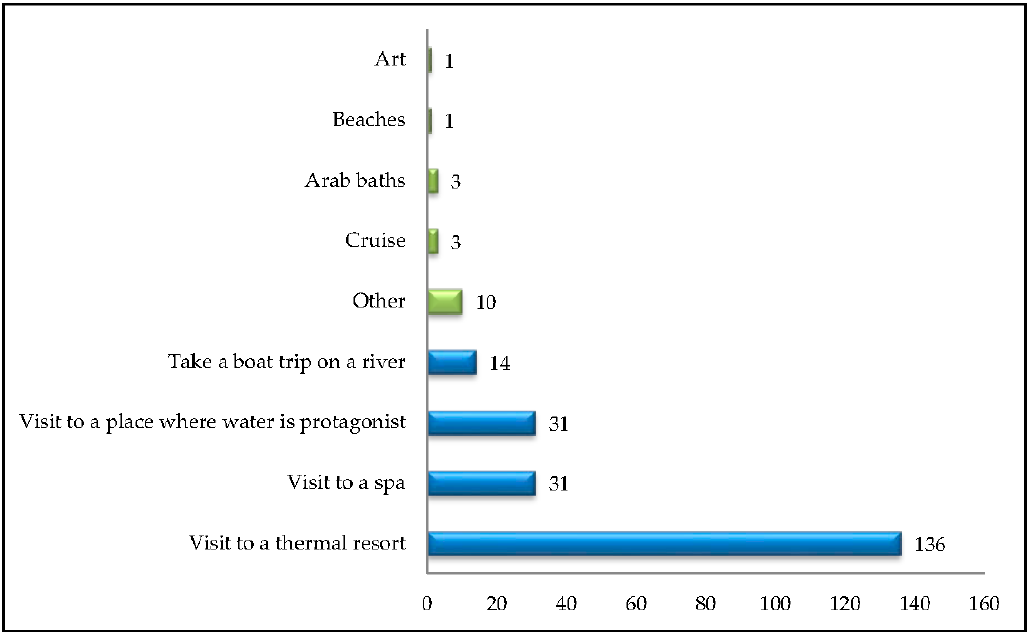
Figure 2. Water-based tourism experience recently